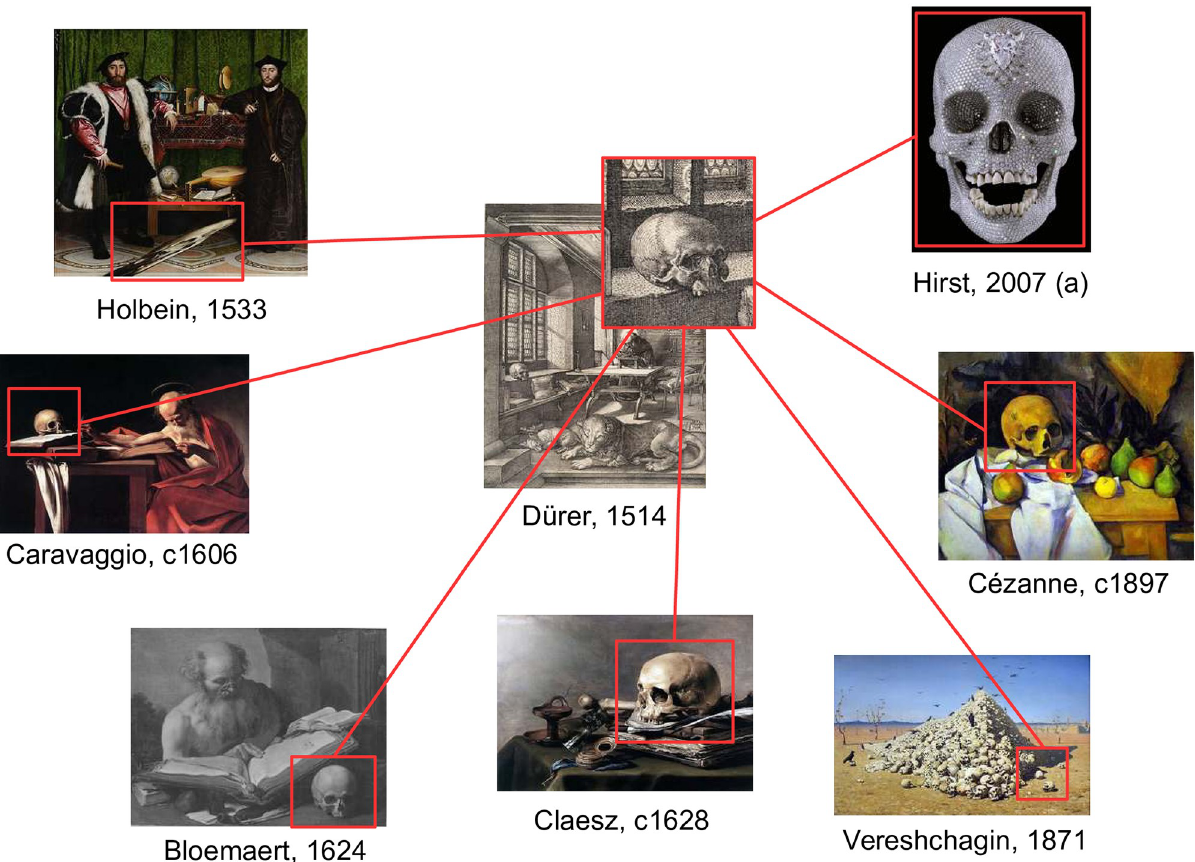
Fig 1. Example of contextual variations of a motif. Artists have painted the skull in different epochs, genres, and techniques. It appears, for example, in Hans Holbein’s The Ambassadors, Caravaggio’s painting of Saint Jerome, and still lives by Pieter Claesz or Modern artist Paul Ce´zanne. While it is always the same object, its symbolic function and meaning intended by the artist varies. For example, in Christian iconography, the skull relates to Saint Jerome, but more often, it refers to the concept of ‘memento mori’– a reminder of human mortality. Finding and tracking such motifs through time and space helps art historians to identify relations between artworks, the meaning and popularity of motifs, or how they have been adapted and sometimes altered in form and content. Image (a) is a slight modification of [4] licensed under CC BY 2.0. The remaining image material is shared by Wikimedia Commons [5] as public